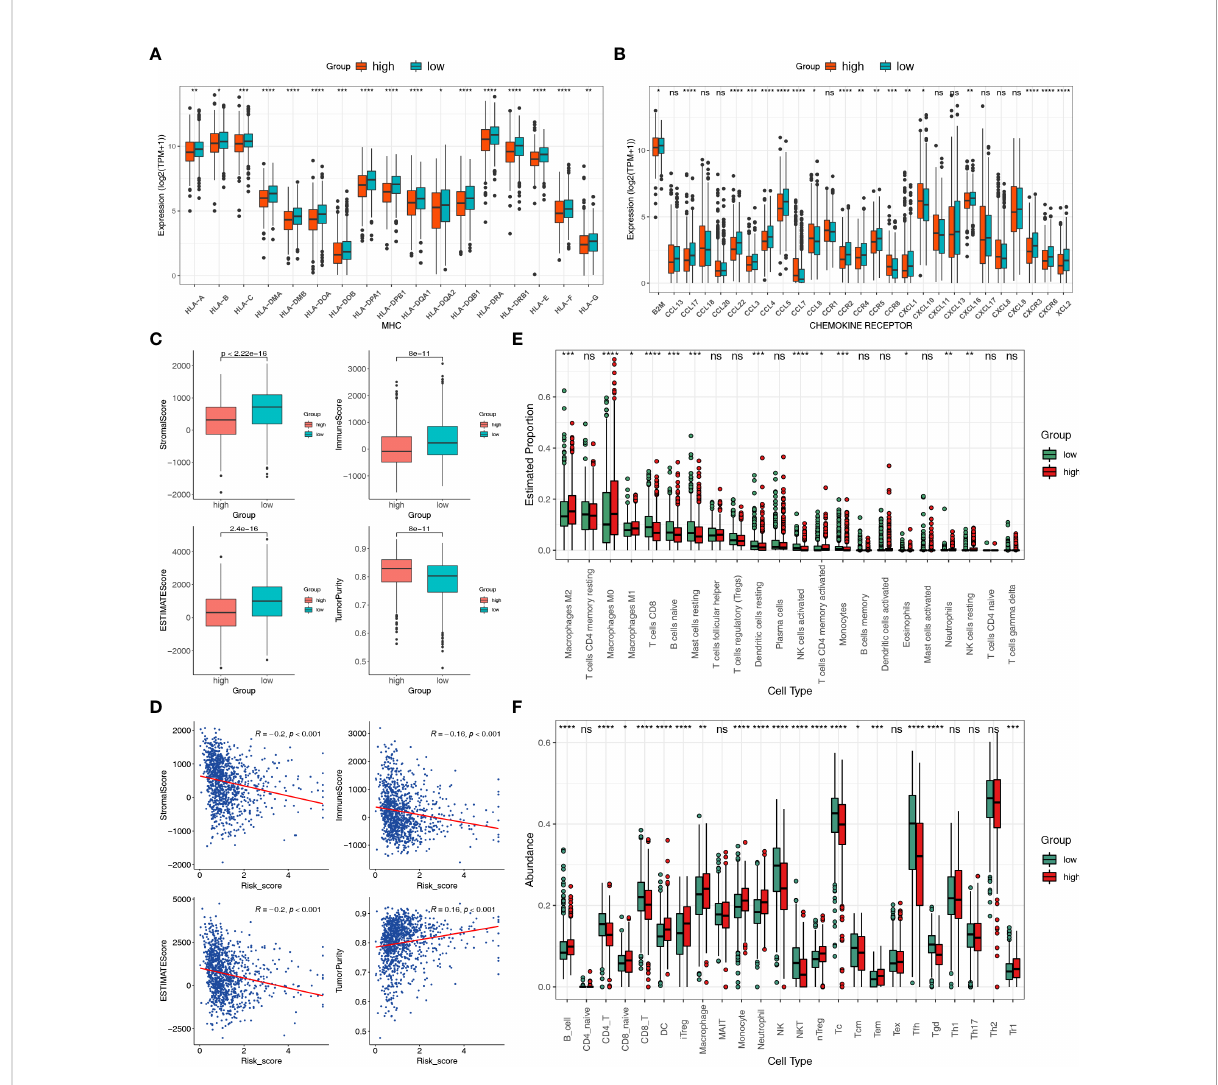
FIGURE 7 Different immune landscapes of the two risk groups. (A) Differences in MHC molecules between the two risk groups. (B) Differences in chemokines and receptors between the two risk groups. (C) Differences in tumor purity, immune, stromal, and estimated scores between the two risk groups. (D) Correlation between the tumor purity, immune, stromal, and estimated scores with the risk score. (E) Differences in in fi ltration fractions of 22 immune cell subsets between the two risk groups according to the CIBERSORTx. (F) Differences in in fi ltration fractions of 24 immune cell subsets between the two risk groups according to the ImmuCellAI database. Statistical signi fi cance at the level of ns>0.05, * ≤ 0.05, ** ≤ 0.01, *** ≤ 0.001 and **** ≤